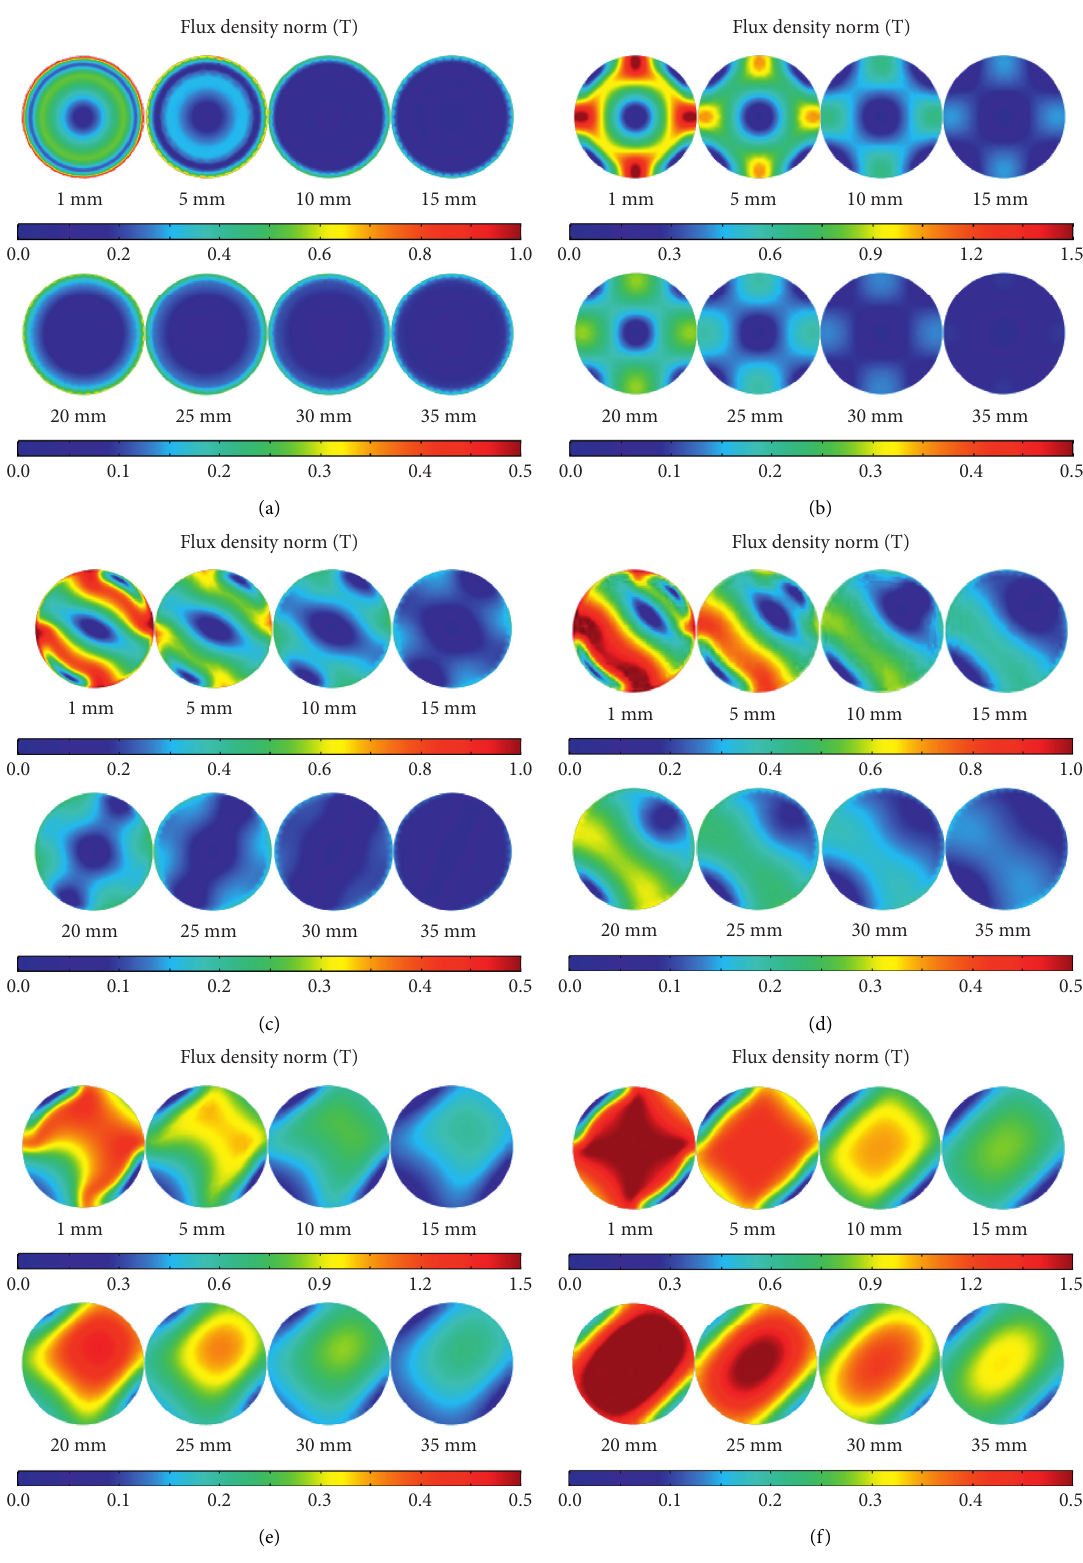
Figure 12: Magnetic flux density norm nephogram of the valve cover when the valve seat consists of four identical shape tile magnets. (a) Scheme 4. (b) Scheme 5. (c) Scheme 6. (d) Scheme 7. (e) Scheme 8. (f) Scheme